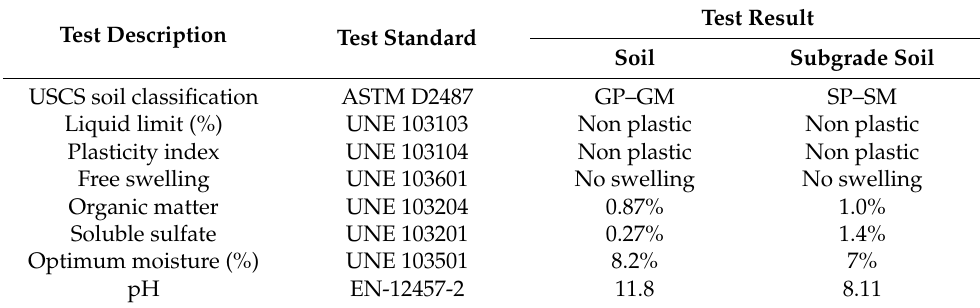
Table 2. Chemical composition of raw materials.